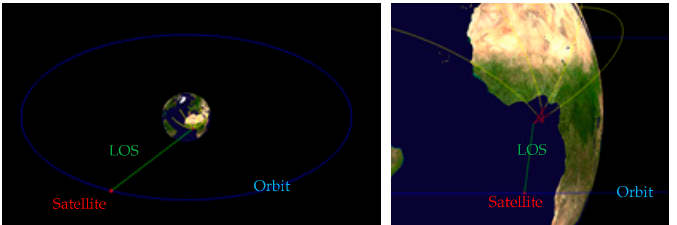
Figure 8. Detection scenario (the left picture is a panorama and the right one is a partial enlargement.